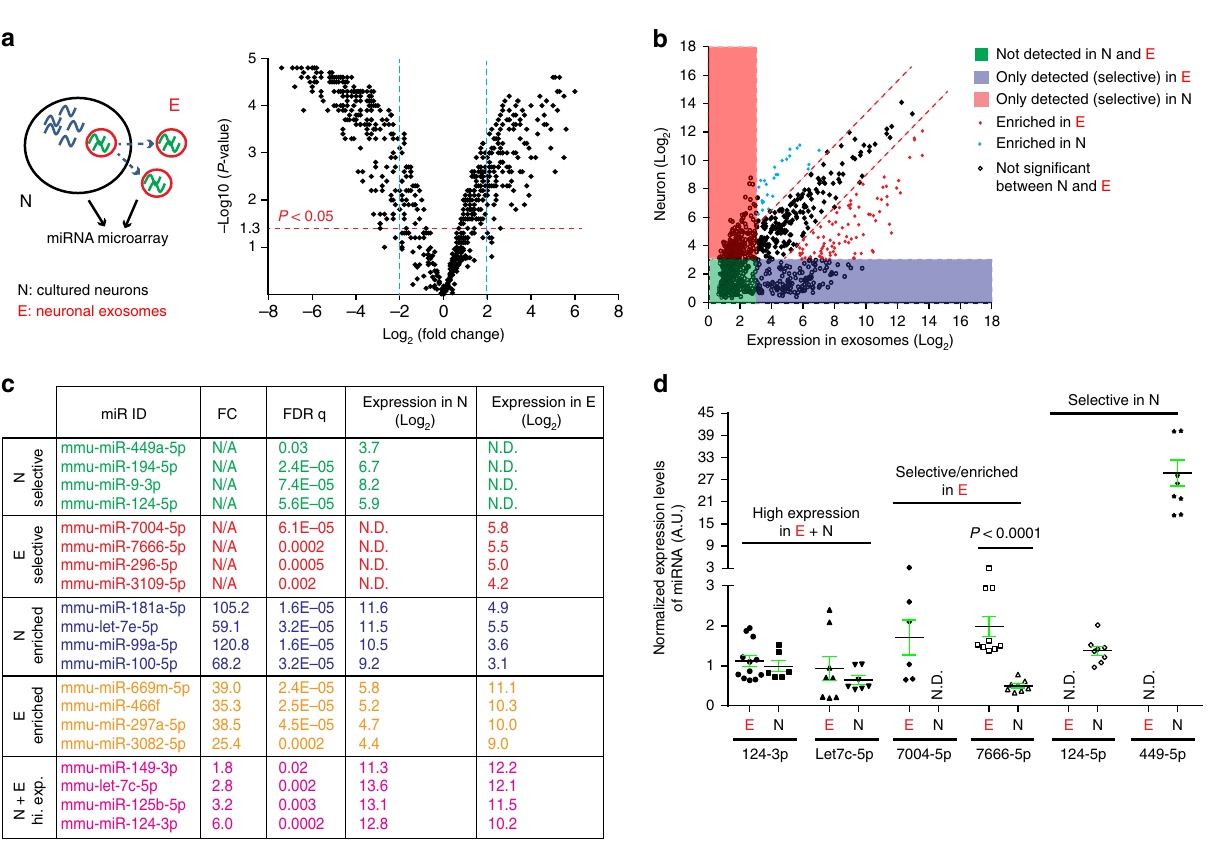
Fig. 5 Neuronal exosomes contain an abundant and selective subset of miRs. a Schematic diagram and volcano plot of differentially expressed neuronal and neuronal exosomal miRs identi fi ed by miR microarray hybridization. n = 3 biologically independent samples per condition. For each independent experiment, exosomes were prepared from same batch of primary neurons from which the total neuronal RNA was also prepared. N: neurons; E: neuronal exosomes; miRs with expression values < 2 3 arbitrary unit (A.U.) from the microarray hybridization are deemed not expressed. b Identi fi cation of enriched or selective miRs contained in either neurons or secreted exosomes by miR microarray hybridization. Green shaded area: miRs not expressed in either neurons or exosomes ( < 2 3 A.U. in both E and N); red shaded area: miRs selectively expressed in neurons ( < 2 3 A.U. in E, > 2 3 A.U. in N, FDR q < 0.05); purple shaded area: miRs selectively expressed in exosomes ( < 2 3 A.U. in N, > 2 3 A.U. in E, FDR q < 0.05); red dots: miRs enriched in E (FC E/N > 4, P < 0.05); blue dots: miRs enriched in N (FC E/N < -4, FDR q < 0.05); black dots: miRs not enriched in either N or E (FC < 4, FDR q < 0.05). c Representative selective or enriched miRs from both neurons and neuronal exosomes, respectively. N.D.: not detected; N/A: not applicable; d Validation of representative miRs that are neuron and exosome selective or enriched, respectively, by qPCR. All original Ct values are within 26 – 32 range, Ct > 34 is deemed not detected (N.D.). U6 small nuclear (sn) RNA was used as the endogenous control. n = 3 – 6 biologically independent samples (four technical replicates/ sample) per condition. P- values were determined from two-tailed unpaired t -test. Error bars were presented in GW4869 inhibits exosome secretion from not only neurons but Cy5-miR-124-3p (alone or co-localized with CD63-GFP, yellow also other cell types, daily administration of GW4869 signi fi cantly and white arrows) in the tdT + astrocyte was further con fi rmed using the 3D astrocyte domain image (Fig. 6c, ii – iv). Additional decreases miR-124-3p levels in isolated eGFP + astrocytes by 80% compared to sham controls (Fig. 6d) without changing pri-miR- examples of intracellular localization of Cy5-miR-124-3p (alone 124 levels in these astrocytes (Fig. 6e). GW4869-induced decrease or co-localized with CD63-GFP, yellow and white arrows) and of miR-124-3p in astrocytes, together with the increased miR- nearby CD63-GFP + exosomes (gray arrows) in tdT + astrocytes 124-3p levels in astrocytes in vivo and in neuronal co-culture were shown in Supplementary Fig. 4f. How miR-associating